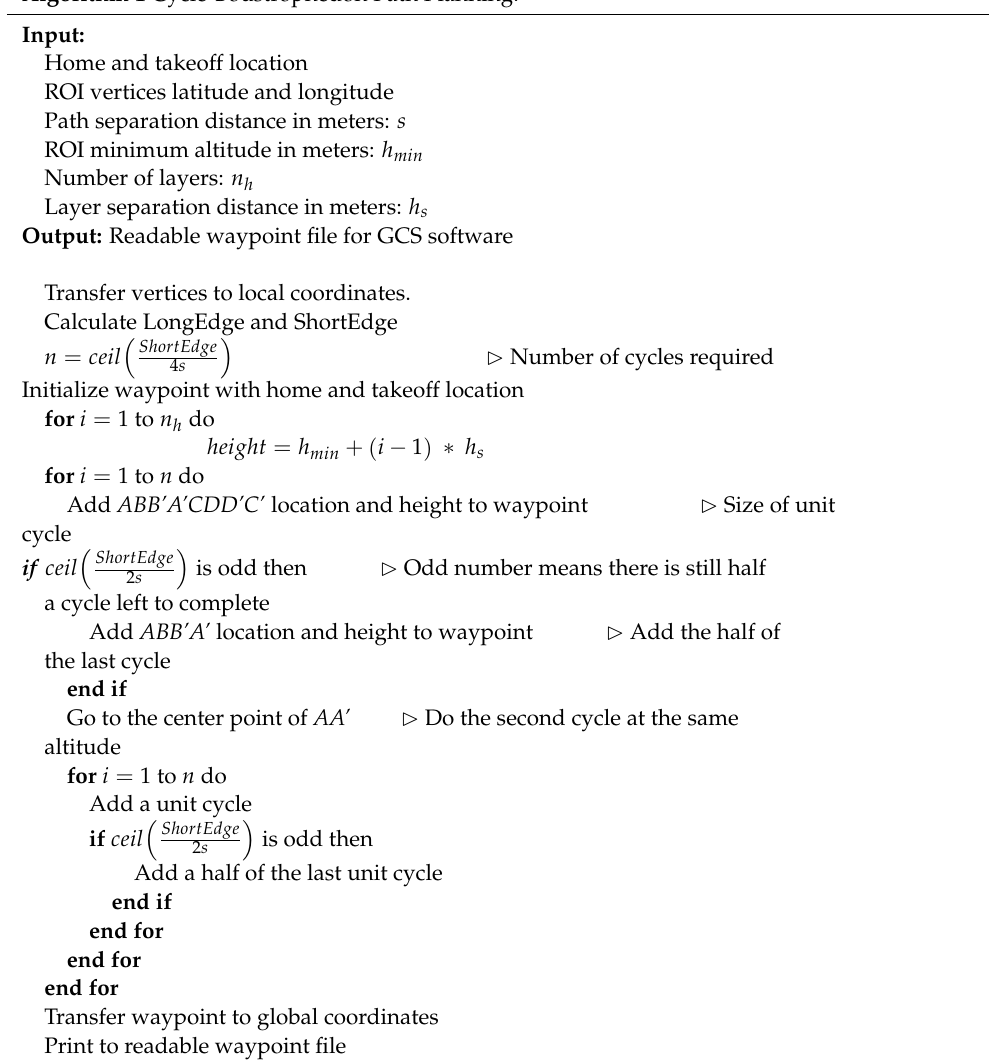
Algorithm 1 Cycle-Boustrophedon Path